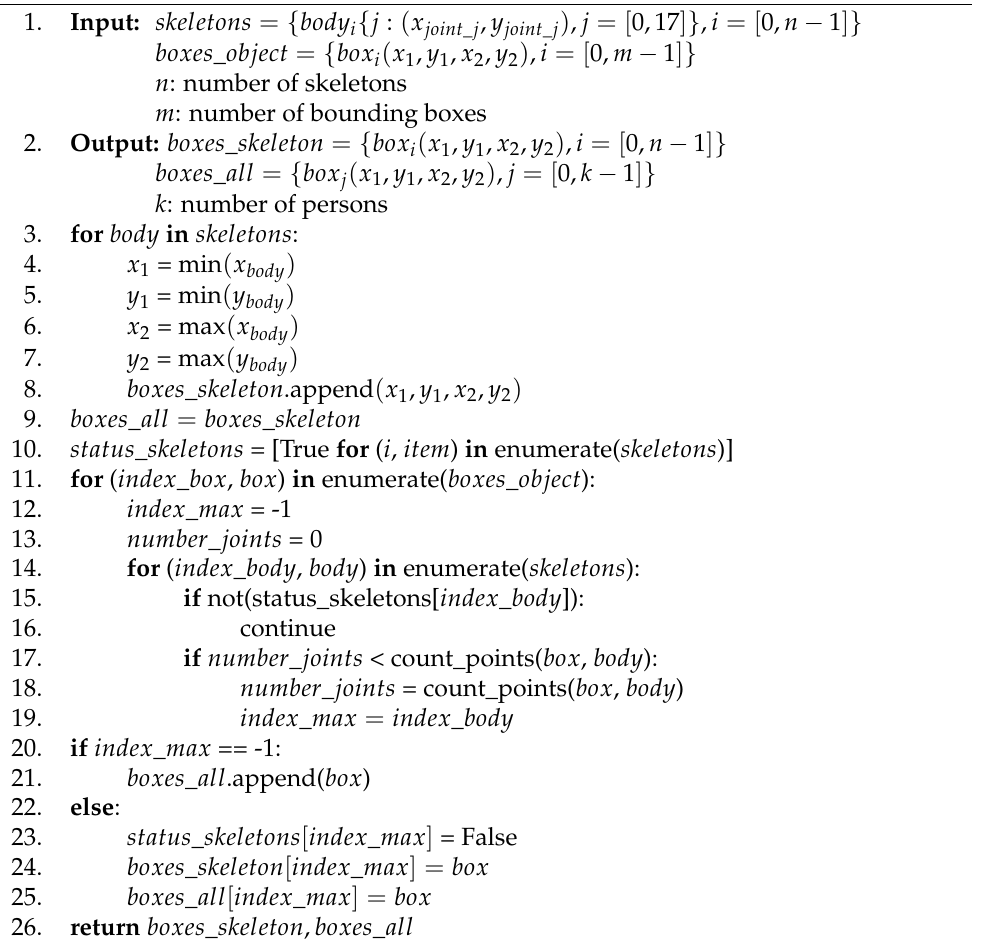
Algorithm 1 Identifying the bounding boxes of each